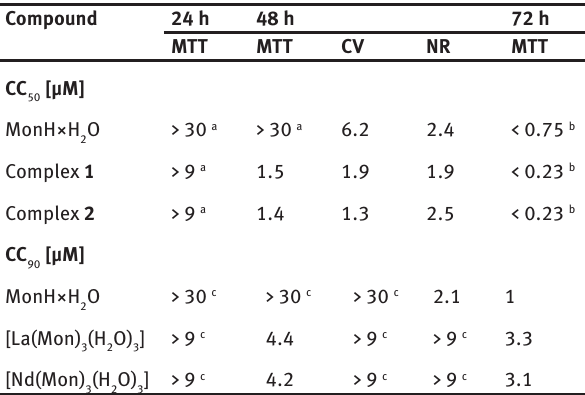
Table 2: Cytotoxic effect of Monensic acid and complexes 1 - 2 on MDA-MB-231 cell line.